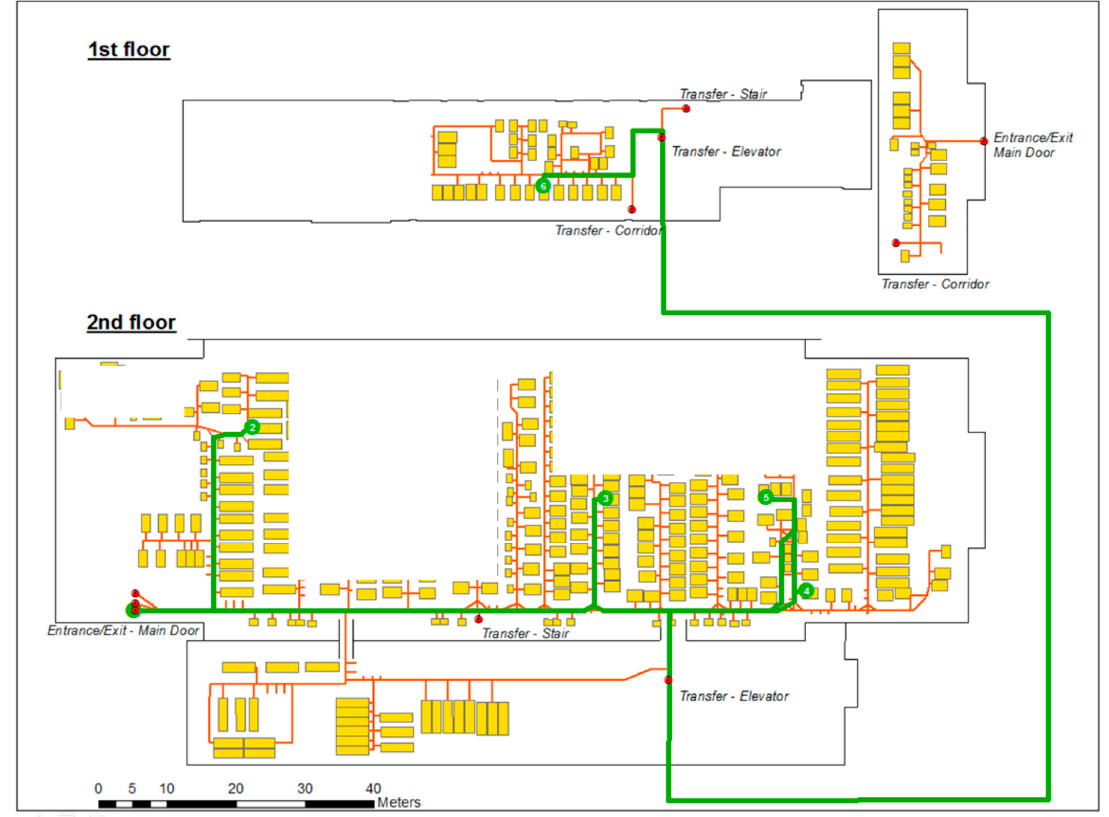
Figure 1. Prototypical application of an affordance-based path calculation for a given production asset (from [3]). The calculated path of a production asset, from entering the production line at node (1) and undergoing several manufacturing steps (nodes 2–6).